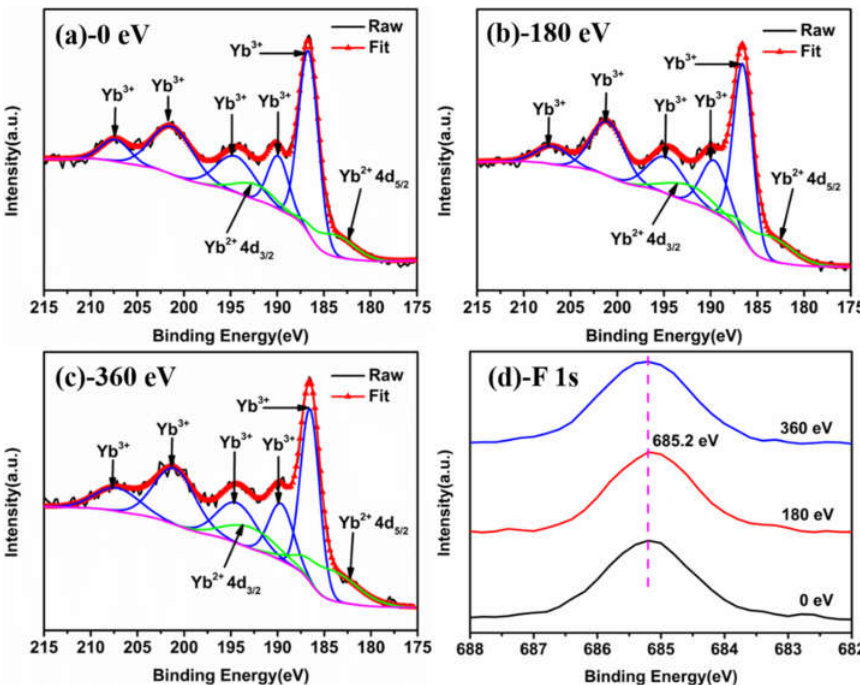
Figure 3. XPS spectra of the YbF 3 films. ( a ) Narrow-scanning XPS spectra of Yb 4d for the film deposited at ion energy of 0 eV. ( b ) Narrow-scanning XPS spectra of Yb 4d for the film deposited at ion energy of 180 eV. ( c ) Narrow-scanning XPS spectra of Yb 4d for the film deposited at ion energy of 360 eV. ( d ) Narrow-scanning XPS spectra of F 1s for the films.